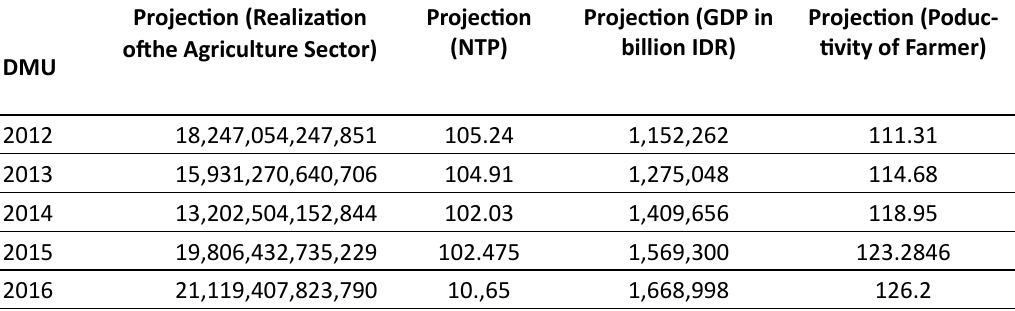
Table 5: Input Projection Needed 2015 (output oriented)